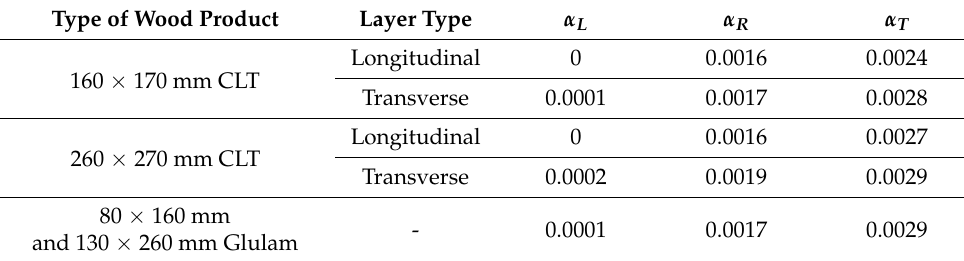
Table 11. Swelling coefficient values for glulam and CLT (from Swelling